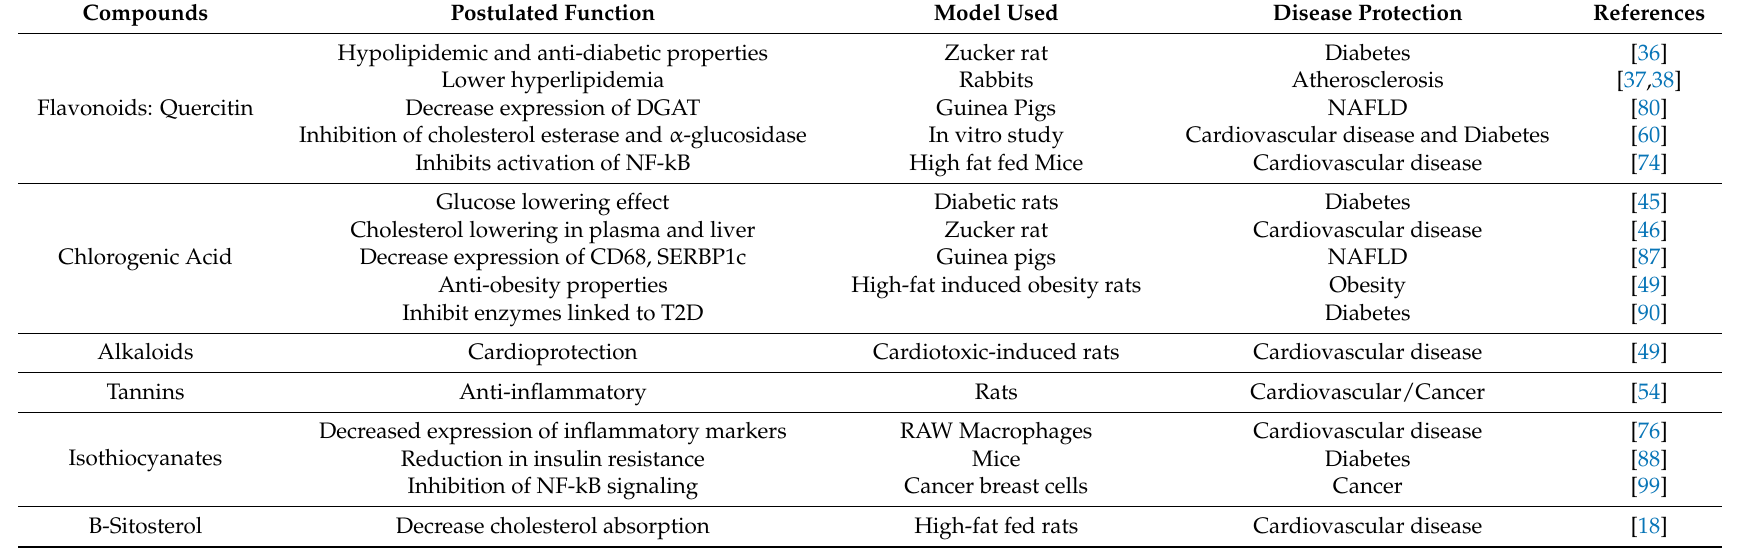
Table 1. Bioactive Components in Moringa Oleifera and their Positive Effects on Chronic